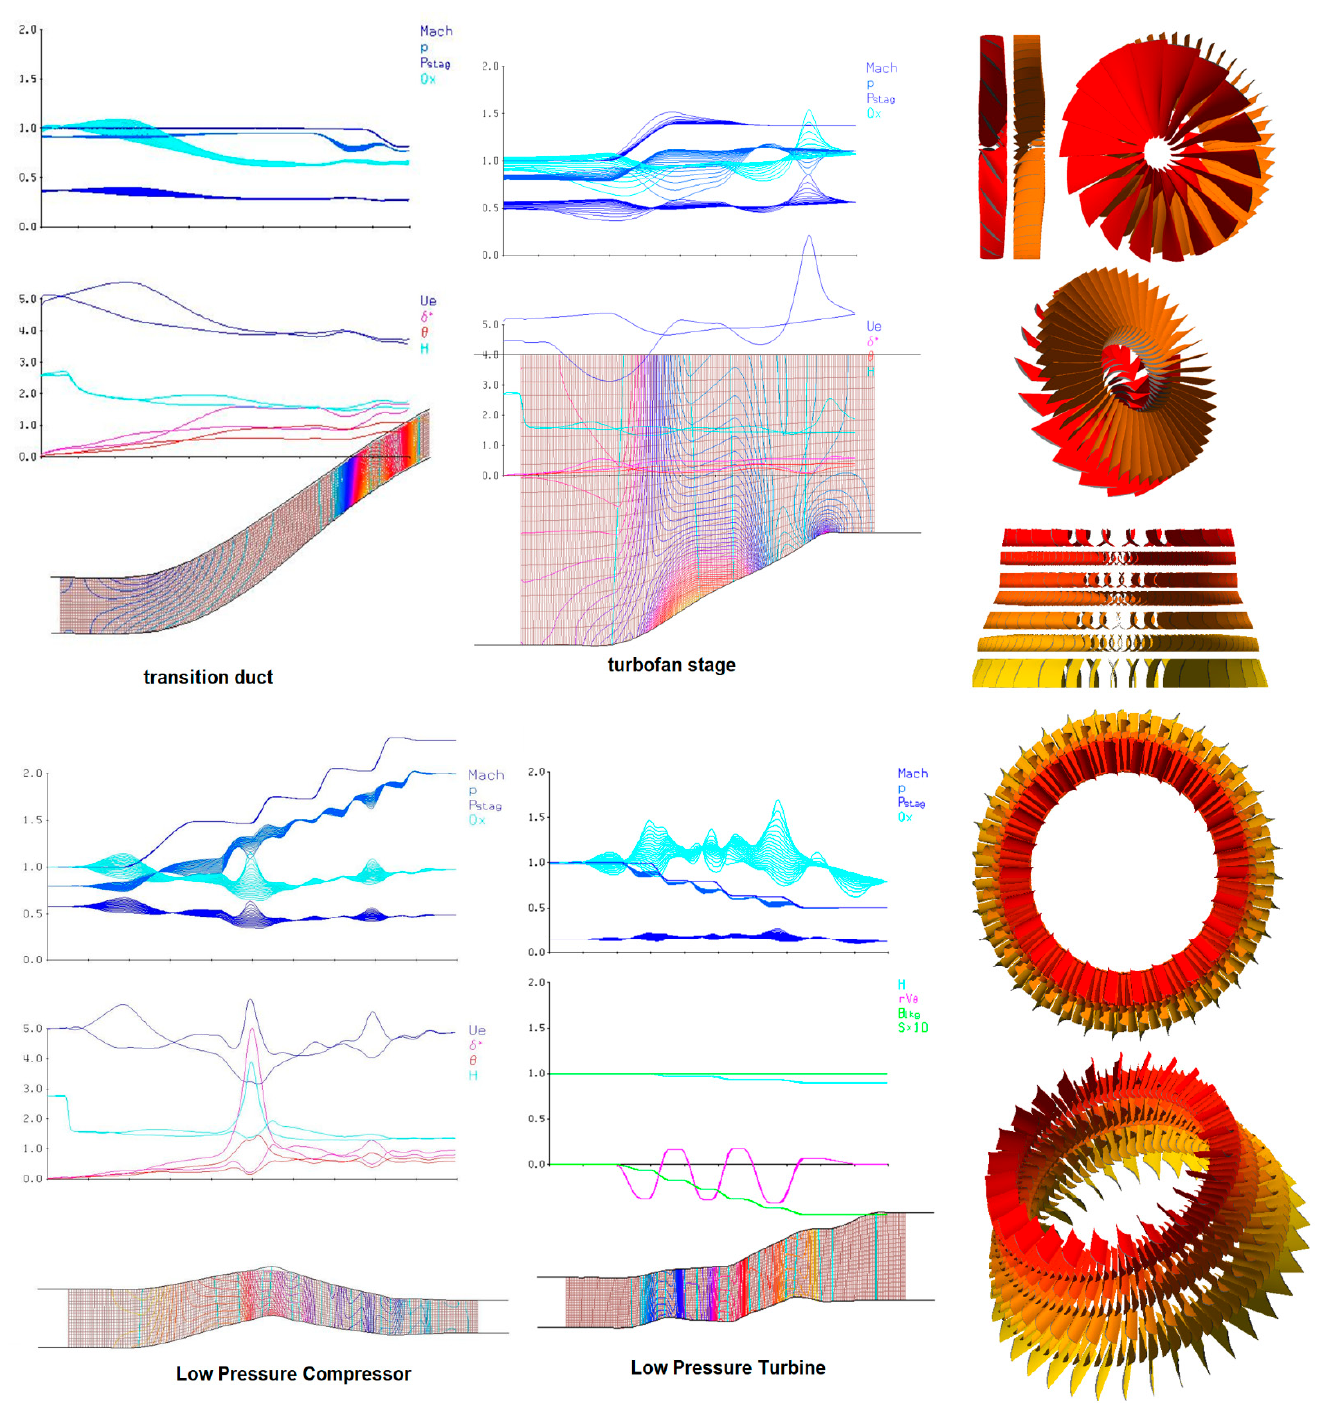
Figure 5. Axisymmetric simulation for ducted machines using T-Axi.